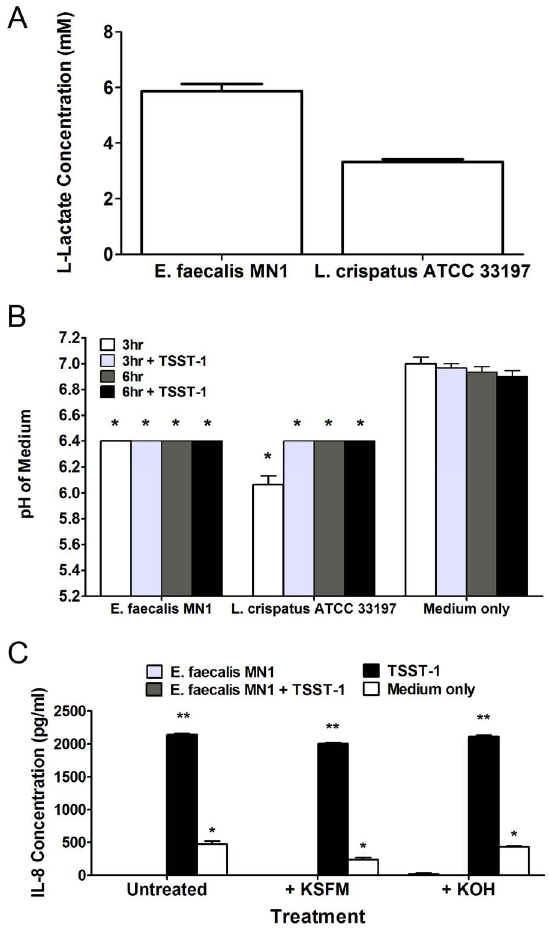
Figure 5. Lactic acid is not solely responsible for IL-8 inhibition. A) E. faecalis MN1 and L. crispatus ATCC 33197 (both at 1 6 10 7 CFU/well) were incubated with TSST-1 (100 m g/ml) on HVECs for 6 h, and lactic acid was measured in the tissue culture medium using a colorimetric assay. B) E. faecalis MN1 and L. crispatus ATCC 33197 (both at 1 6 10 7 CFU) were incubated 6 TSST-1 (100 m g/ml) with HVECs for 6 h, and the pH of the tissue culture media was measured after 3 and 6 h. All conditions with enterococci or lactobacilli were significantly lower than the TSST-1 or medium only controls at 3 h and 6 h by individual Student’s t tests (p , 0.001). C) Cells were incubated with E. faecalis